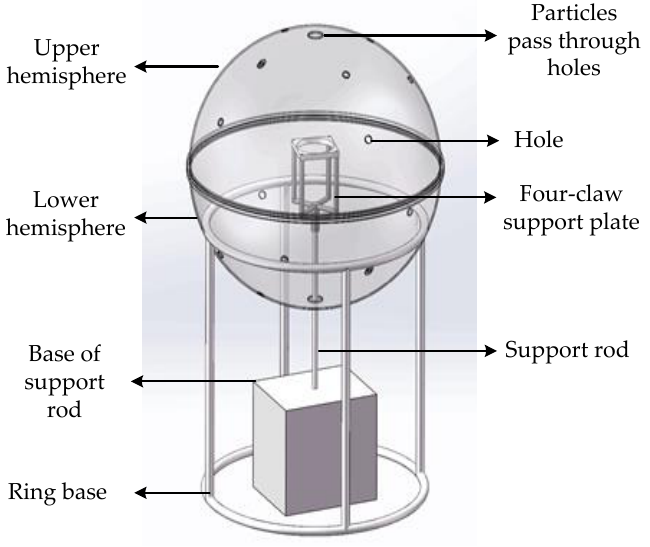
Figure 1. Schematic diagram of the methane-measurement simulation chamber. The outer diameter of the chamber is 0.5 m, and the wall thickness is 3 mm. The chamber is divided into upper and lower hemispheres, which are mounted on a ring- shaped base. The middle of the sphere can be opened. A thin rod passes through the chamber directly below the center in order to support a fan and hold a sensor. Mounted on this thin metal rod is a four-claw support plate that can slide up and down. A fan can be placed on the four-claw support plate, such that its height can be adjusted and fixed on the thin, metal rod inside the